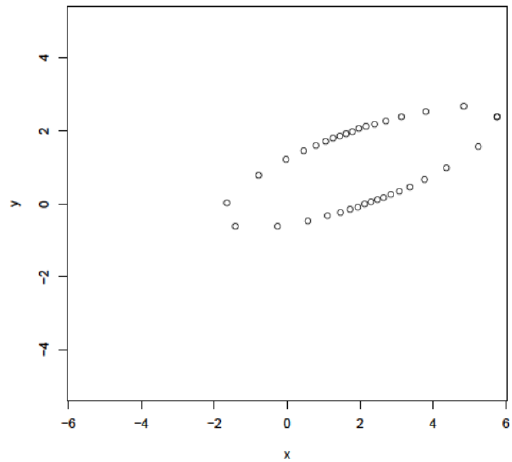
Figure 1: An ellipse used for approximating an inclusion in a steel